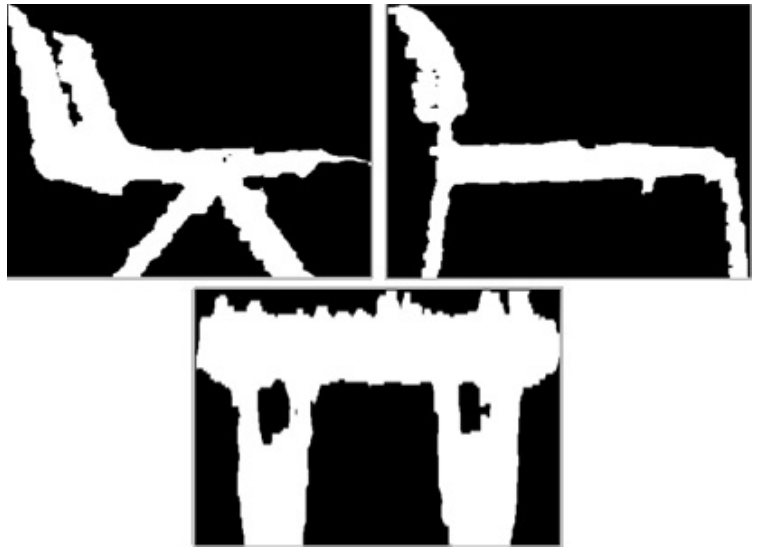
Figure 16. Experiment 2, contours